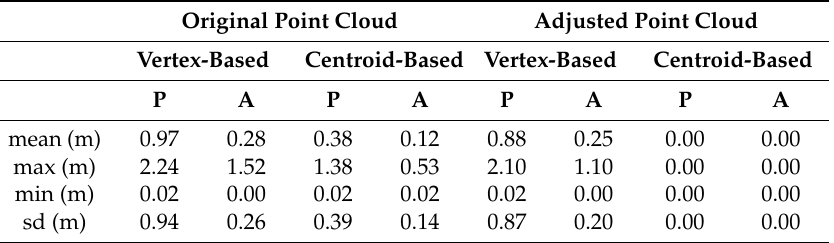
Table 1. Main statistics to summarize the graphs show in Figure 6a,b (original point cloud), c, and d (adjusted point cloud). The “vertex-based” columns refer to the distance between the vertices and the corresponding tie objects. The “centroid-based” columns refer to the distance between the centroids and the tie objects. All rows of the last two columns equal zero because the tie object location overlaps the centroid of the vertices. P and A stand for Planimetric and Altimetric